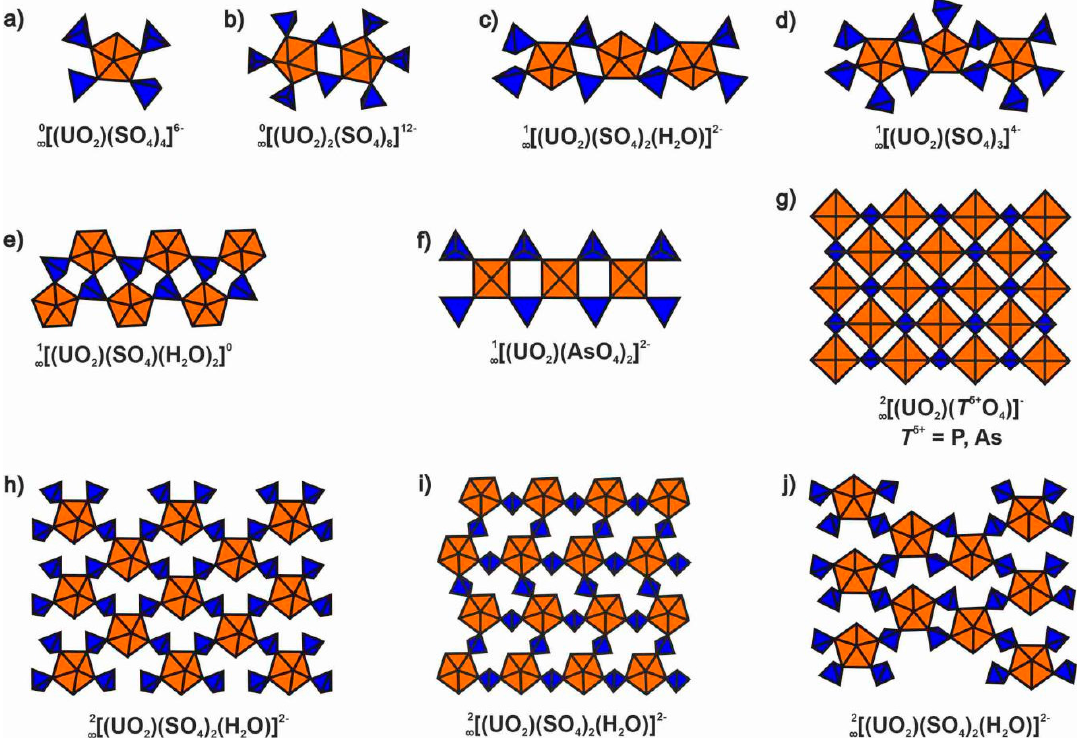
Figure 1. Heteropolyhedral complexes with corner sharing only between UO n bipyramids and T O 4 tetrahedra in the mineral crystal structures: ( a ) belakovskiite, ( b ) bluelizardite, ( c ) bobcookite, ( d ) meisserite, ( e ) shumwayite, ( f ) walpurgite, ( g ) autunite, ( h ) straßmannite, ( i ) wetherillite and ( j ) beshtauite.